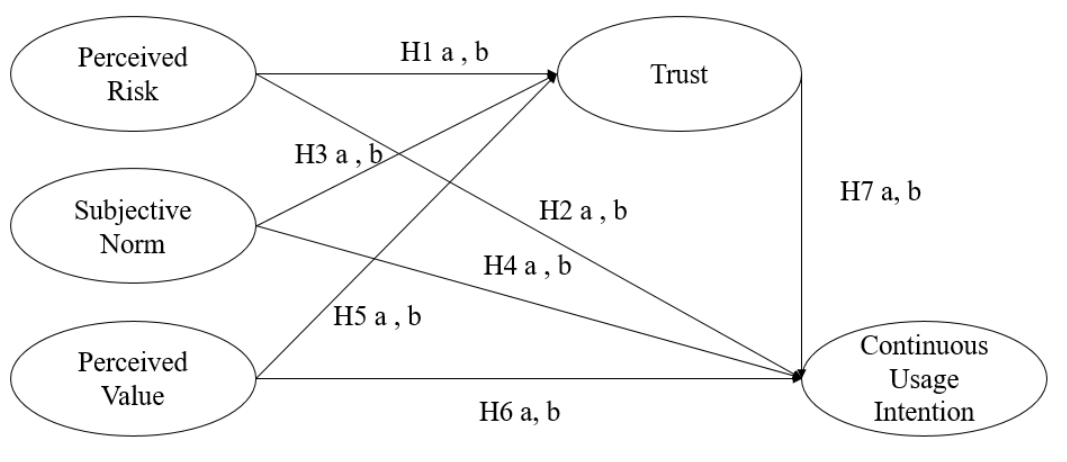
Fig. 1. Conceptual